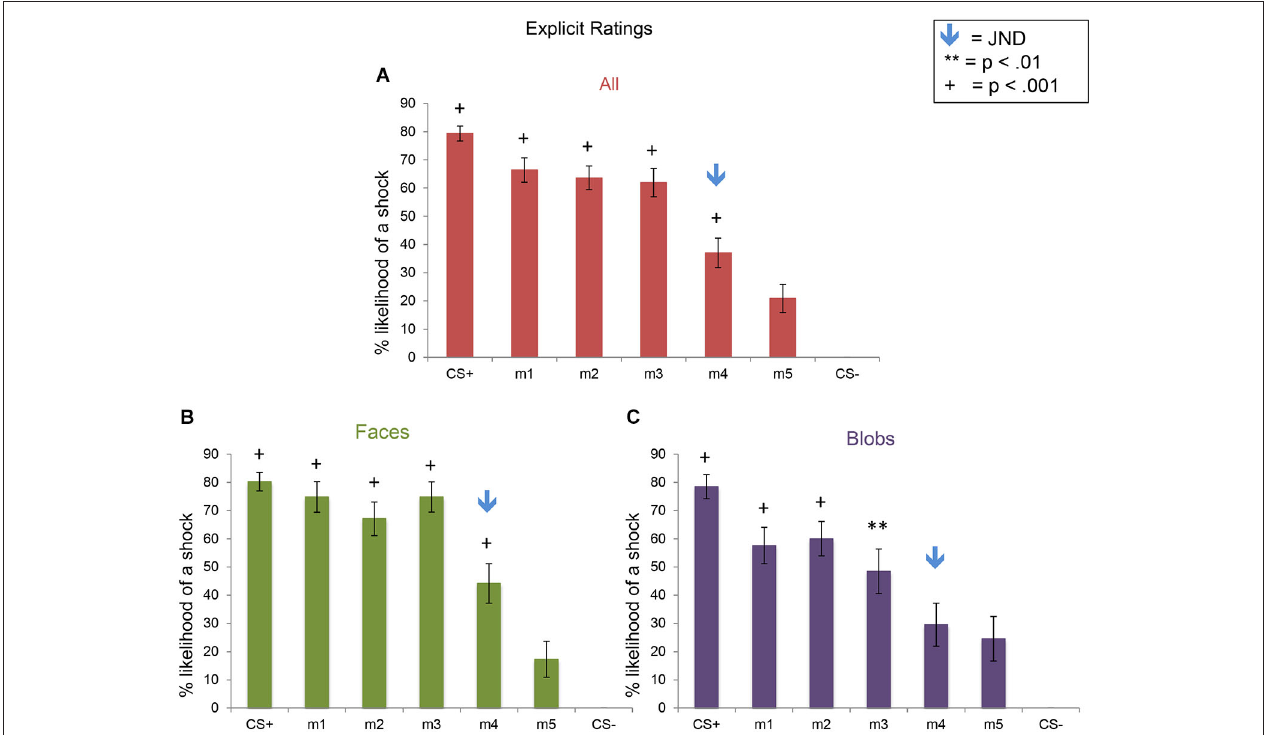
showed significantly greater fear shock likelihood ratings to the CS+ ( t ( 23 ) = 9.00, p = 5 × 10 − 9 ), m1 ( t ( 23 ) = 7.24, p = 2 × 10 − 7 ), m2 ( t ( 23 ) = 7.10, p = 3 × 10 − 7 ), m3 ( t ( 23 ) = 8.12, p = 3 × 10 − 8 ), and m4 ( t ( 23 ) = 3.87, p = 0.0008) in Experiment 1 (faces), and to the CS+ ( t ( 22 ) = 5.90, p = 6